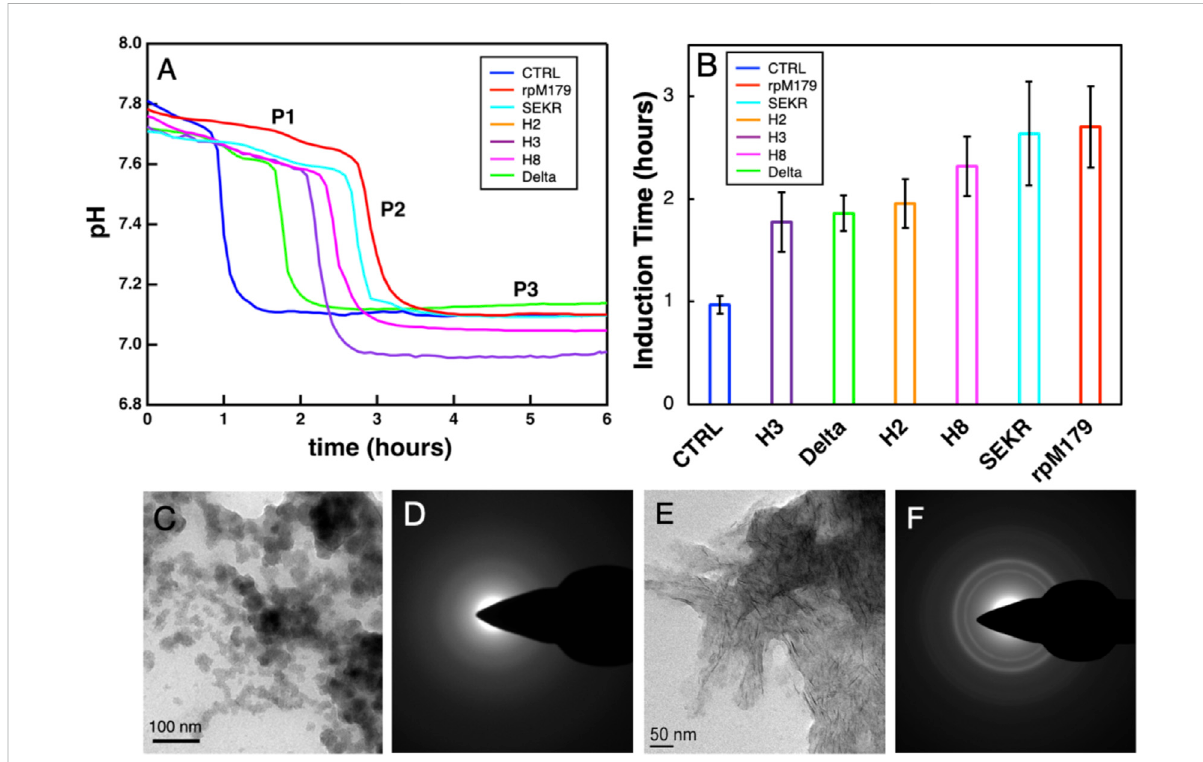
FIGURE 5 (A) Typical curves for the kinetics of mineralization of calcium phosphate in the absence of protein (CTRL) or the presence of 200 μ g/ml wild- type and mechanistic probe proteins at 22 ° C. The rpM179 curve (red) is labeled to show the different stages of mineralization: P1, the formation of ACP; P2, the ACP to HAP transition region; and P3, the growth and ripening of HAP. (B) Mean induction times (duration of P1) for the ACP to HAP phase transformation listed from the shortest induction time to the longest induction time. (C) TEM image showing ACP nanoparticles